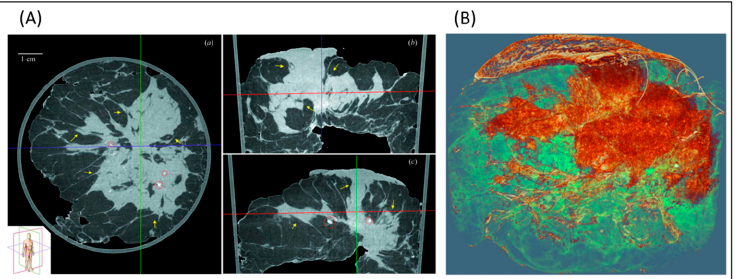
Figure 3. CT with SXR for excised breast. ( A ) transaxial, coronal, and sagittal view of the excised breast and ( B ) 3D rendered image of the same breast. The parenchymal distortion and speculations are clearly visible along with the tumor into the skin. Reprinted with permission from [23].